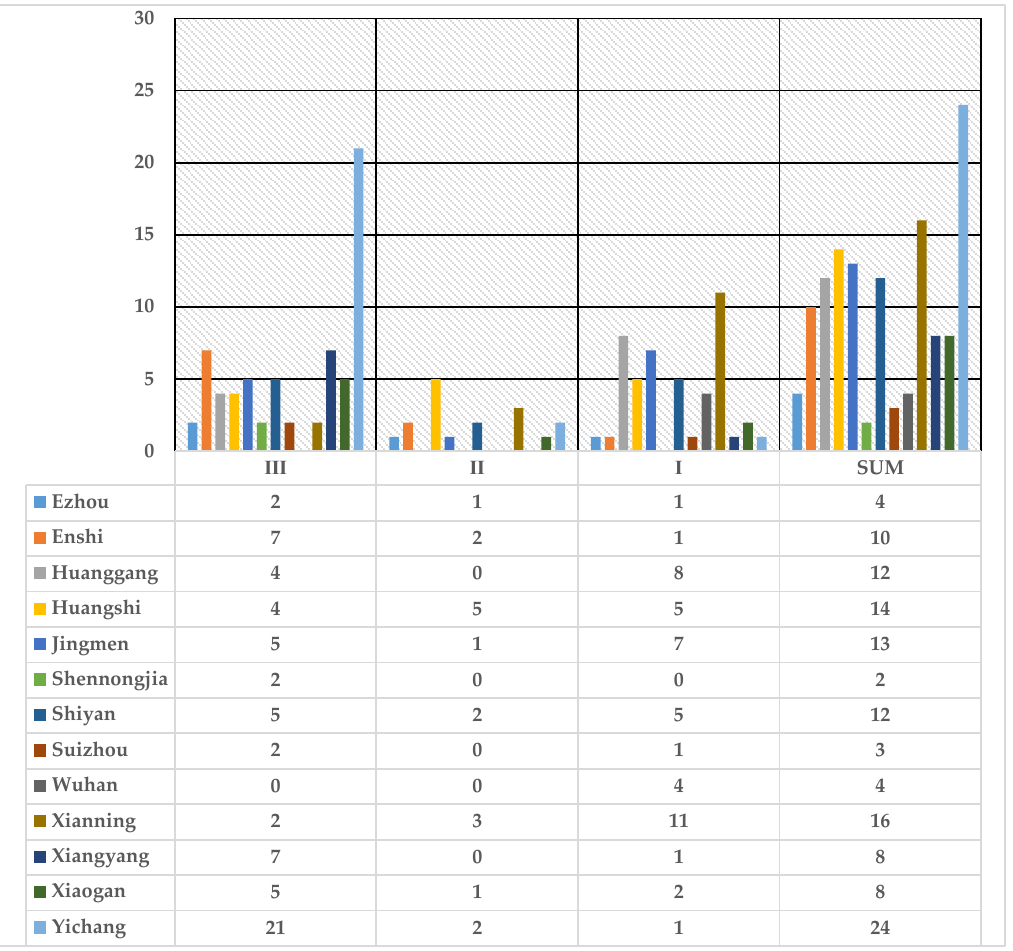
Figure 13. The damage s rate of the topographical landscape of cities in Hubei. Table 3. The scale of land occupation and destruction evaluation.